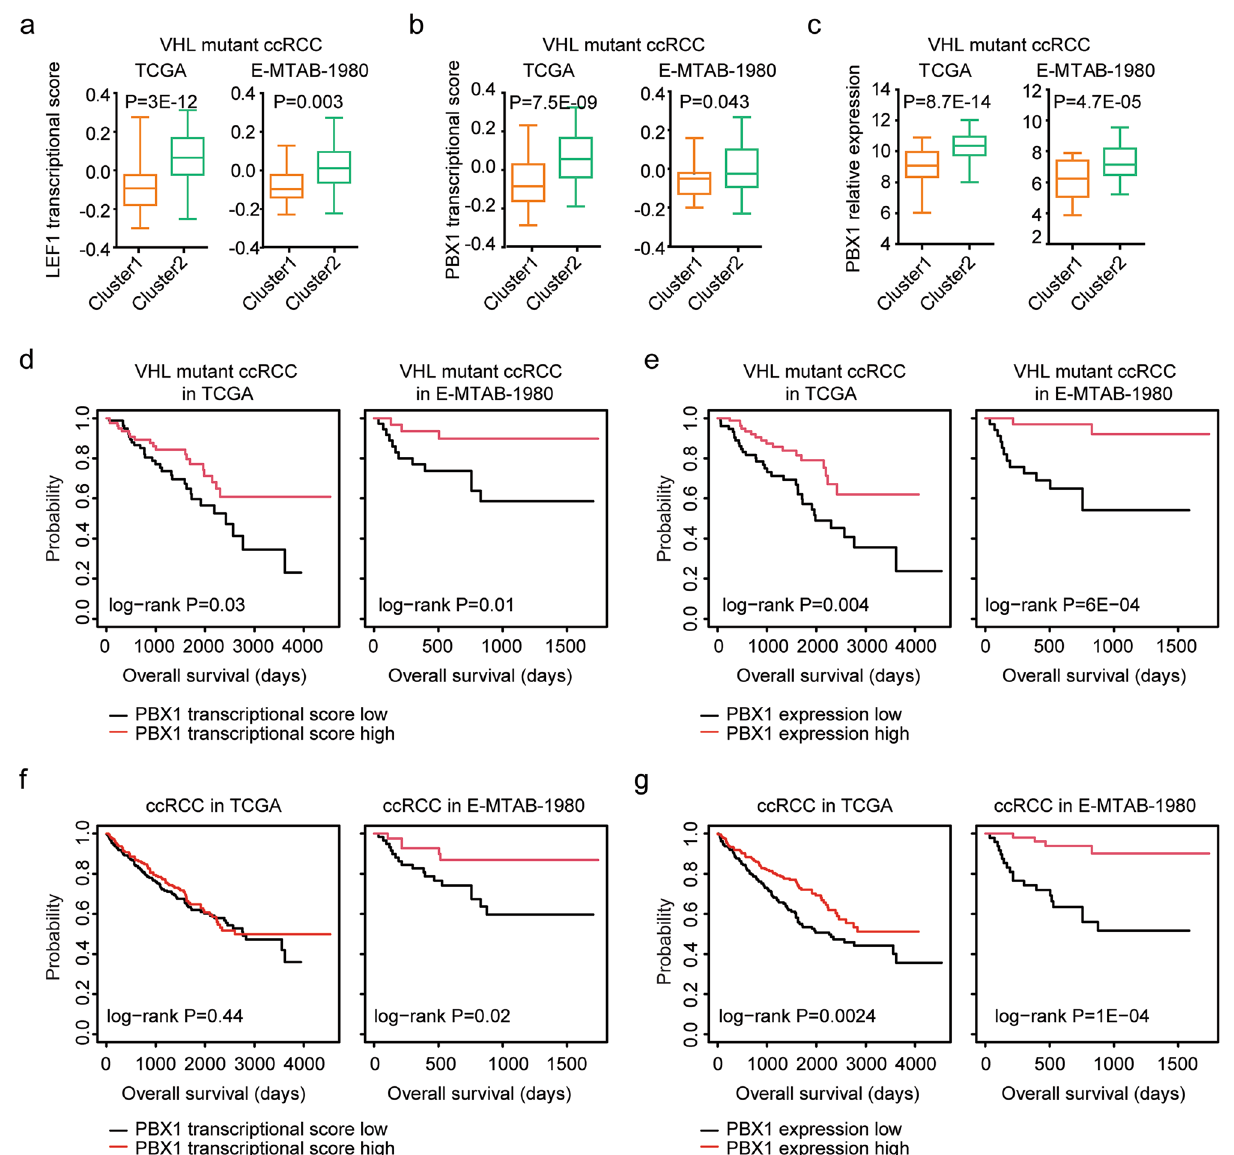
Figure 3. Transcription factor PBX1 is associated with the classification and prognosis of VHL mutant ccRCC. ( a ) The transcriptional scores of LEF1 in sub-cluster1 and sub-cluster2 VHL mutant ccRCC patients in TCGA and E-MTAB-1980 datasets. ( b ) The transcriptional scores of PBX1 in sub-cluster1 and sub-cluster2 VHL mutant ccRCC patients in TCGA and E-MTAB-1980 datasets. ( c ) The expression levels of PBX1 in sub-cluster1 and sub-cluster2 VHL mutant ccRCC patients in TCGA and E-MTAB-1980 datasets. ( d ) Kaplan–Meier Plotters showed the associations of the transcriptional scores of PBX1 and the overall survival of VHL mutant ccRCC in TCGA and E-MTAB-1980 datasets. ( e ) The associations of the expression levels of PBX1 and the overall survival of VHL mutant ccRCC in TCGA and E-MTAB-1980 datasets. ( f ) The associations of the transcriptional scores of PBX1 and the overall survival of ccRCC in TCGA and E-MTAB-1980 datasets. ( g ) The associations of the expression levels of PBX1 and the overall survival of ccRCC in TCGA and E-MTAB-1980. Also, scores of 958 transcriptional gene sets in VHL mutant ccRCC patients in TCGA and E-MTAB-1980 datasets were identified using ssGSEA. LEF1 is a downstream transcription factor of WNT sign- aling pathway. Consistent with the lower scores of WNT signaling pathway, LEF1 transcriptional scores were lower in sub-cluster1 VHL mutant ccRCC (Fig. 3a). Moreover, the higher transcriptional scores of LEF1 were associated with the better prognosis of VHL mutant ccRCC in TCGA and E-MTAB-1980 datasets (Supplemen- tary Fig. 2b). However, the mRNA expression levels of LEF1 were not associated with the prognosis of VHL mutant ccRCC in TCGA and E-MTAB-1980 datasets (Supplementary Fig. 2c). PBX1 is a homeobox transcription factor. Insufficiency PBX1 activity is associated with congenital anoma- lies of kidney 39,40 . However, the prognosis of PBX1 in ccRCC, particularly in VHL mutant ccRCC patients is